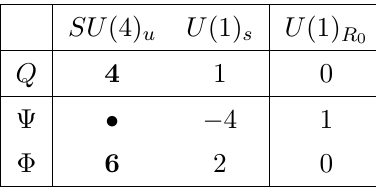
Table 1 . Transformation rules of the matter fields of theory T A under the global